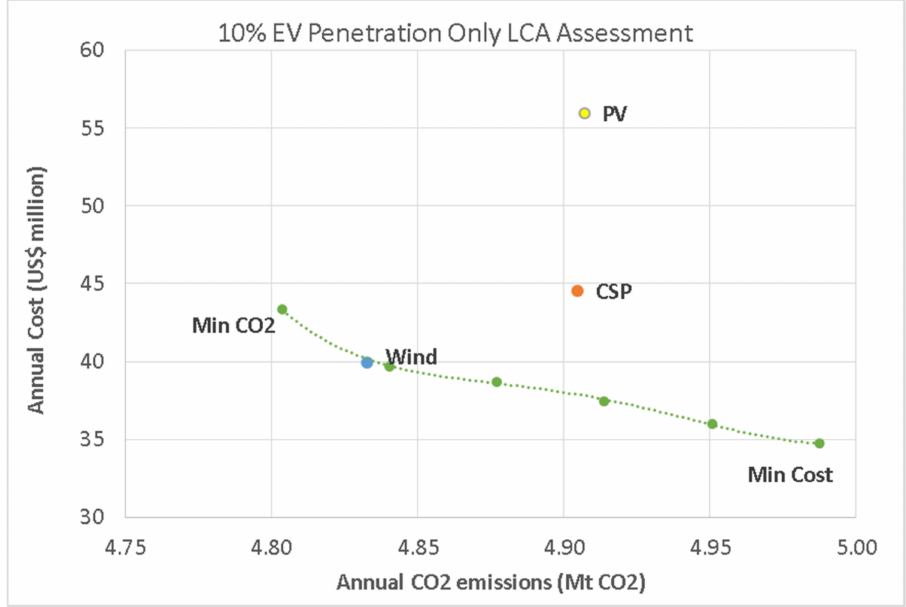
Figure 9. Trade-off between annual cost and CO 2 emissions in different case studies for meeting 10% EV whilst considering life-cycle emissions using different energy